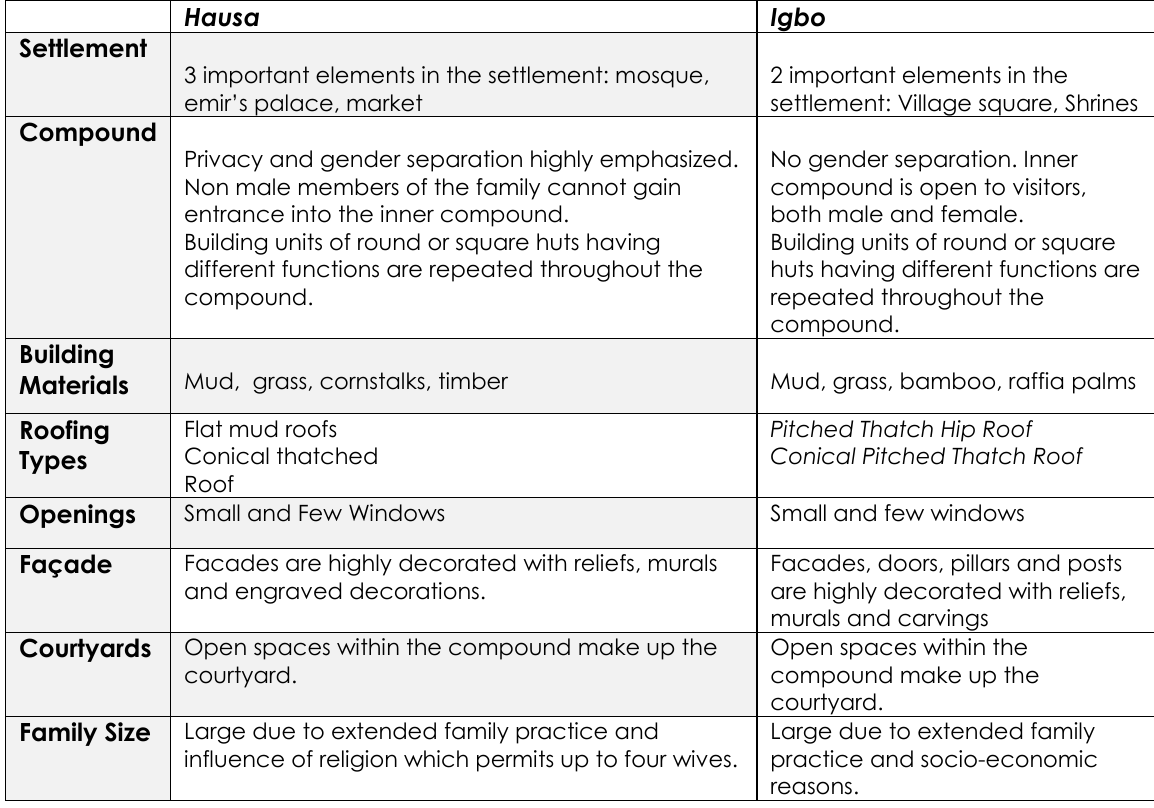
Table 1. Comparison between Traditional Hausa and Igbo